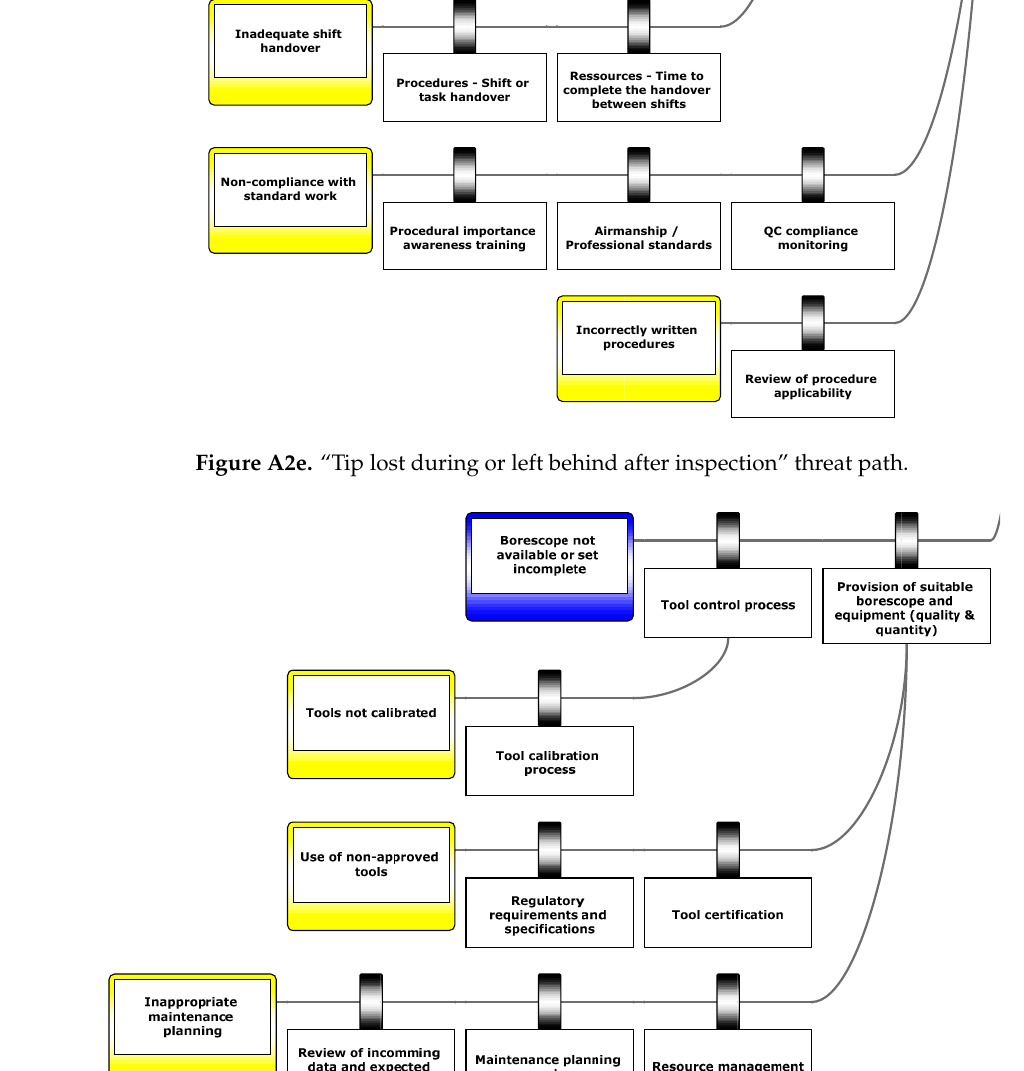
Figure A2f. “Borescope not available or set incomplete” threat paths.